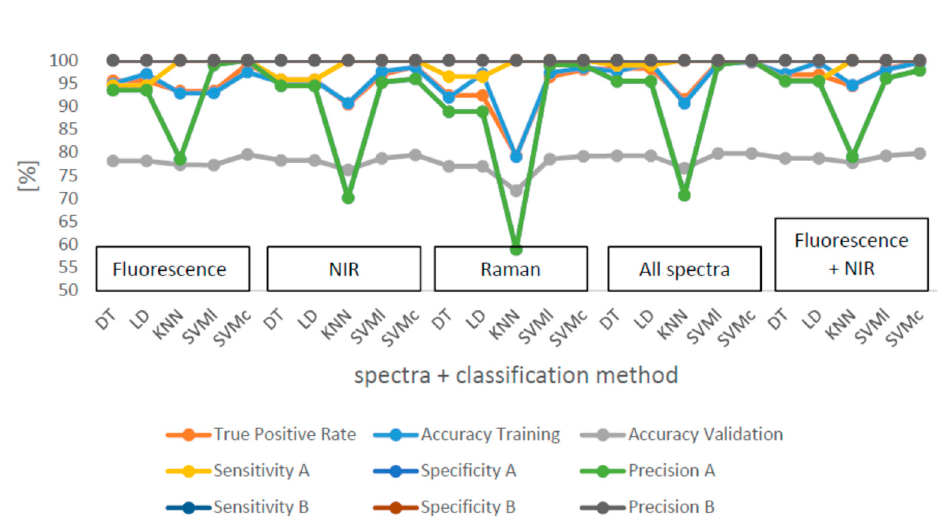
Figure 5. Median of 10 runs for TPR, accuracy of training and validation, sensitivity, specificity and precision of the classification for all evaluated spectra and combined variations as well as different classification methods; DT: decision tree, LD: linear discriminant analysis, KNN: nearest neighbour classification, SVMl and SVMc: support vector machines linear and cubic.